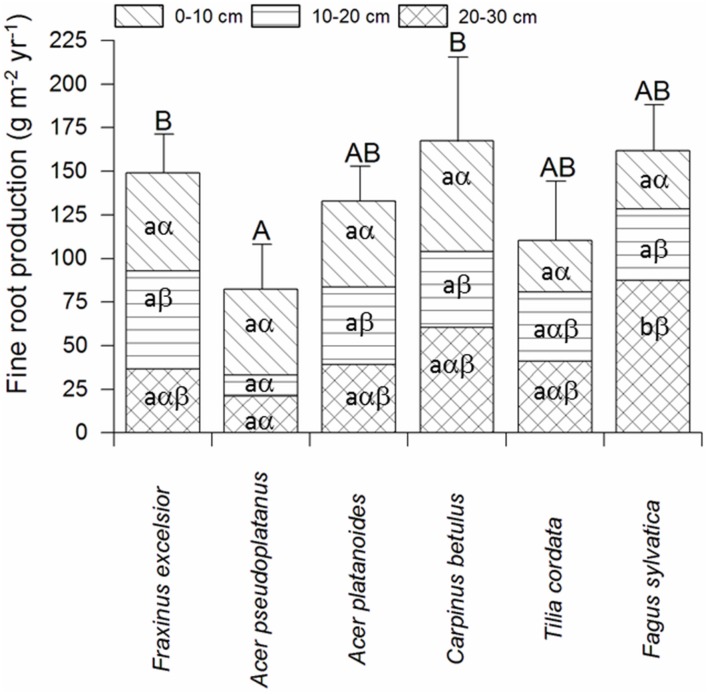
Fine root productivity (FRP) of the six tree species in the three soil depths according to the ingrowth core study (mean ± SE; n = 8 plots). Different capital letters indicate significant differences (p < 0.05) between the species in the soil profile (0–30 cm); significant differences between the soil depths for a given species are indicated by different lower case Latin letters, differences between tree species within a given soil depth by lower case Greek letters.